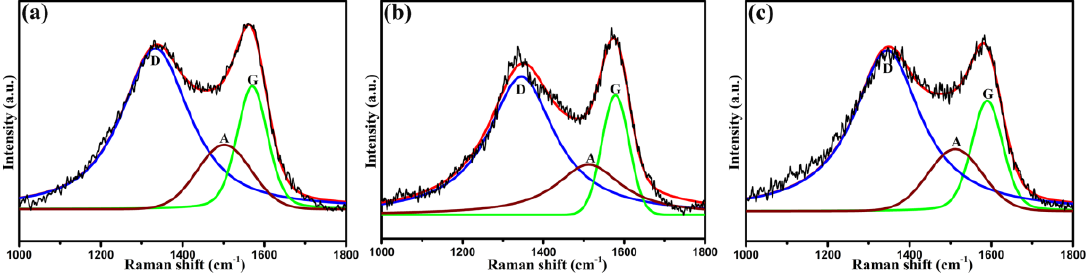
Figure 3. Raman spectra and curve fitting for the CFs: ( a ) untreated CF, ( b ) CF-OH, and ( c ) CF-cardanol.